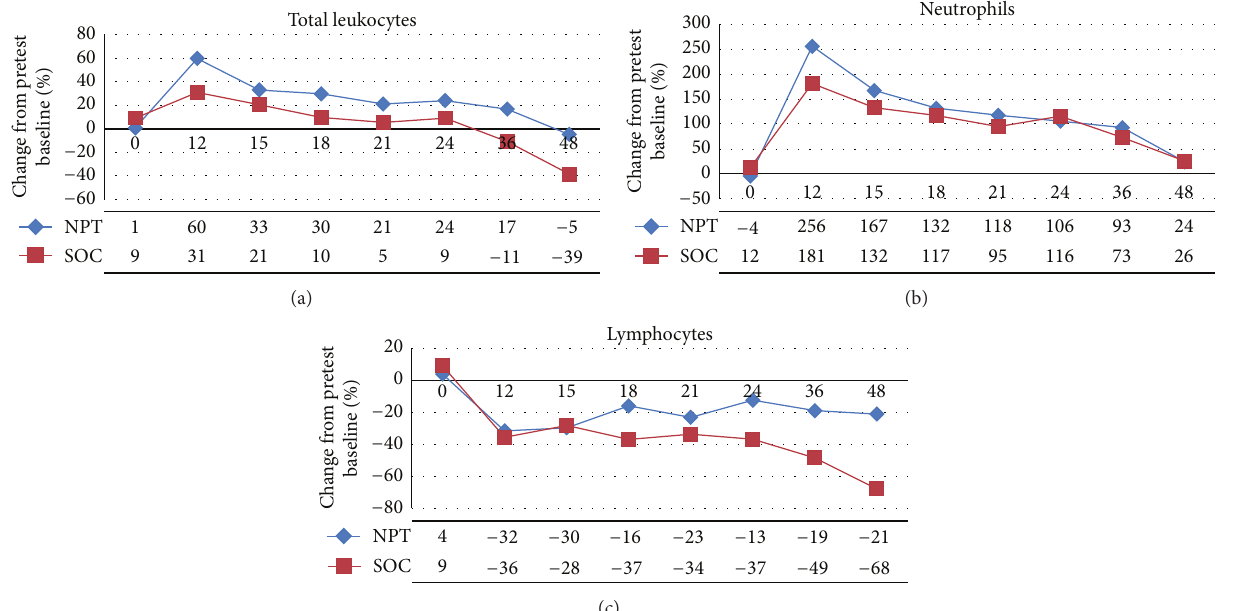
Figure 3: Hematology. The percent change (in the number of total circulating leukocytes, Panel (a)), neutrophils (Panel (b)), and lymphocytes (Panel (c)) in surviving animals over the duration of the experiment showed leukocytosis consisting predominantly of neutrophils that peaked at 12hrs after injury and was observed during most of the experimental period in both treatment groups. Lymphopenia was observed beginning as early as 12hrs after injury in both groups but progressed steadily in the SOC group, which was significantly greater than in the NPT group ( ∗ 𝑝 < 0.05 ).